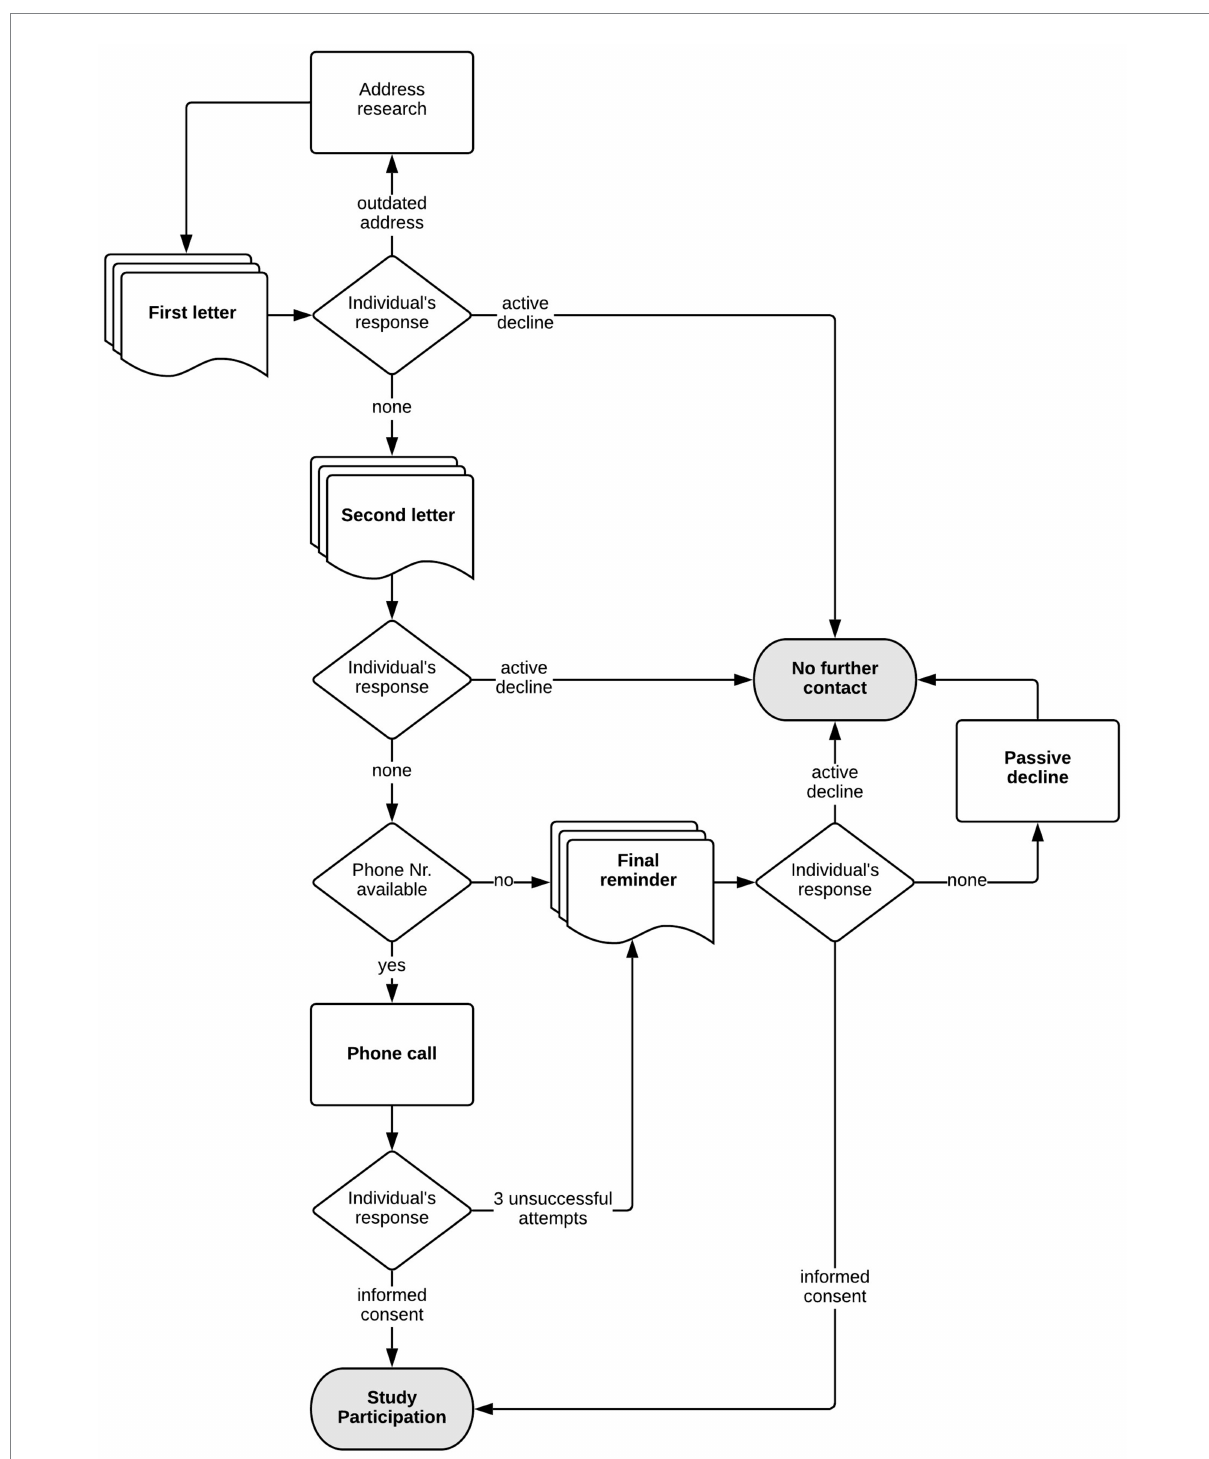
FIGURE 1 Recruitment